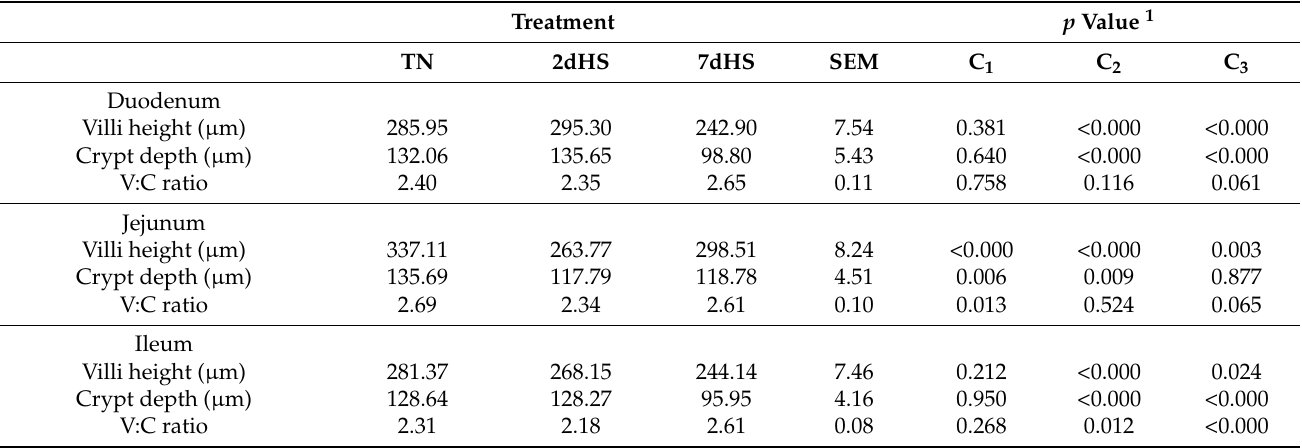
Table 6. Histological characteristic of small intestinal epithelium at duodenum, jejunum, and ileum of pigs exposed to thermoneutral (TN), 2 days (2dHS), or 7 days (7dHS) of heat stress conditions. Treatment